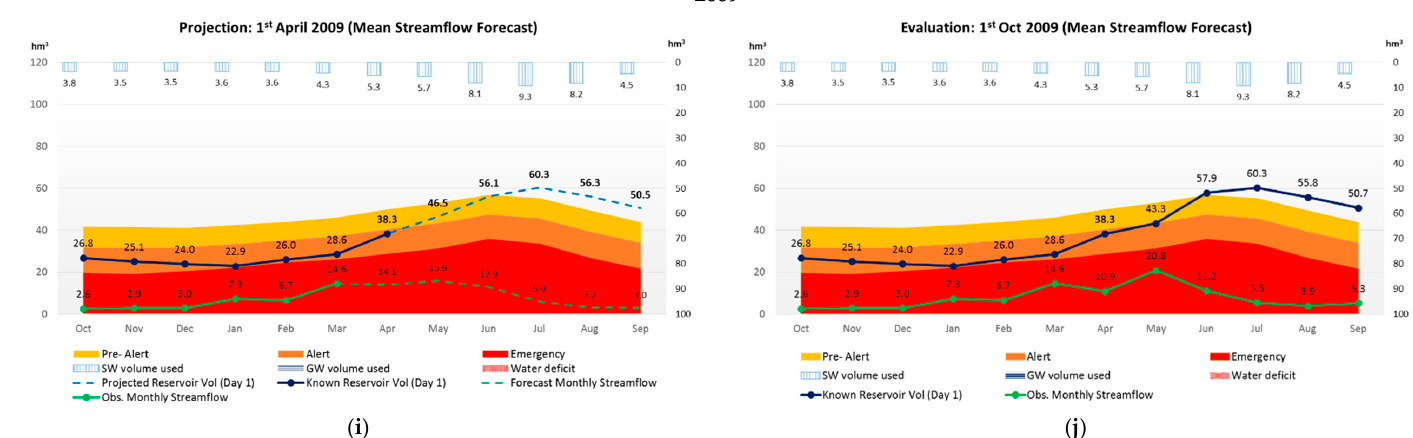
Figure 7. Using streamflow forecast models (in this case, AQUAFOR): Measures taken in April ( a,c,e,g,i ) and evaluation of the real situation made in October ( b,d,f,h,j ).